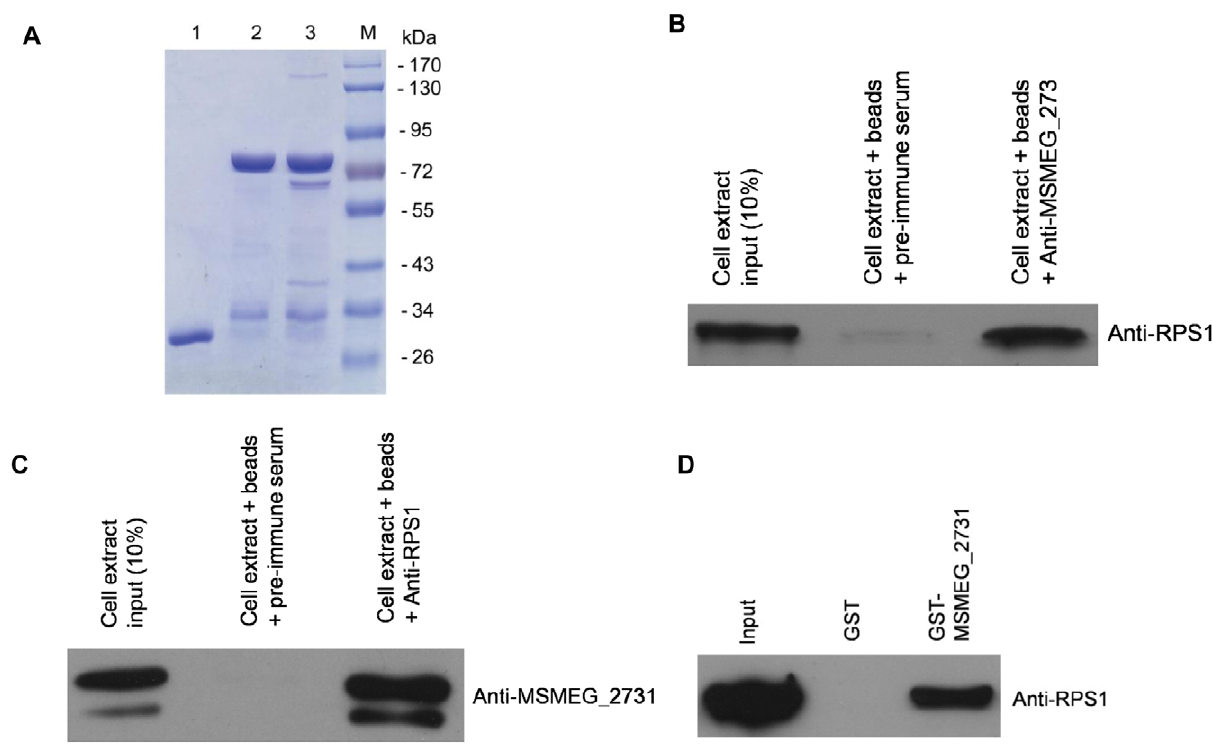
Figure 3. Isolation of MSMEG_2731 binding proteins by GST pull-down assays. (A) GST pull-down assay were performed as described in the materials and methods. Lane 1, GST incubated with cell lysates; lane 2, GST-MSMEG_2731 incubated with PBS; lane 3, GST-MSMEG_2731 incubated with cell lysates; lane 4, protein molecular markers. Several significant bands present in lane 3 but not in lane 1 and 2 were excised for identification by LC-MS/MS. (B) Verification of the interaction between MSMEG_2731 and RPS1. Endogenous RPS1 was immunoprecipitated with anti- MSMEG_2731 serum from M. smegmatis cell extracts, but not with pre-immune antiserum. The immunoprecipitated proteins were detected with anti- RPS1 serum. Ten percent of the cell extract was loaded as a control. (C) Endogenous MSMEG_2731 was immunoprecipitated with anti-RPS1 serum from M. semegmatis cell extracts, but not with pre-immune antiserum. (D) GST pull-down assay for examining the interaction between MSMEG_2731 and RPS1. Equimolar amounts of RPS1 combined with GST-MSMEG_2731 were used for the pull-down assay. GST was used as a negative control. The mixture was incubated for 1 h at 16 u C, and then purified using a GST affinity assay. Samples were examined by Western blotting. RPS1 was pulled down by GST-MSMEG_2731, but not by